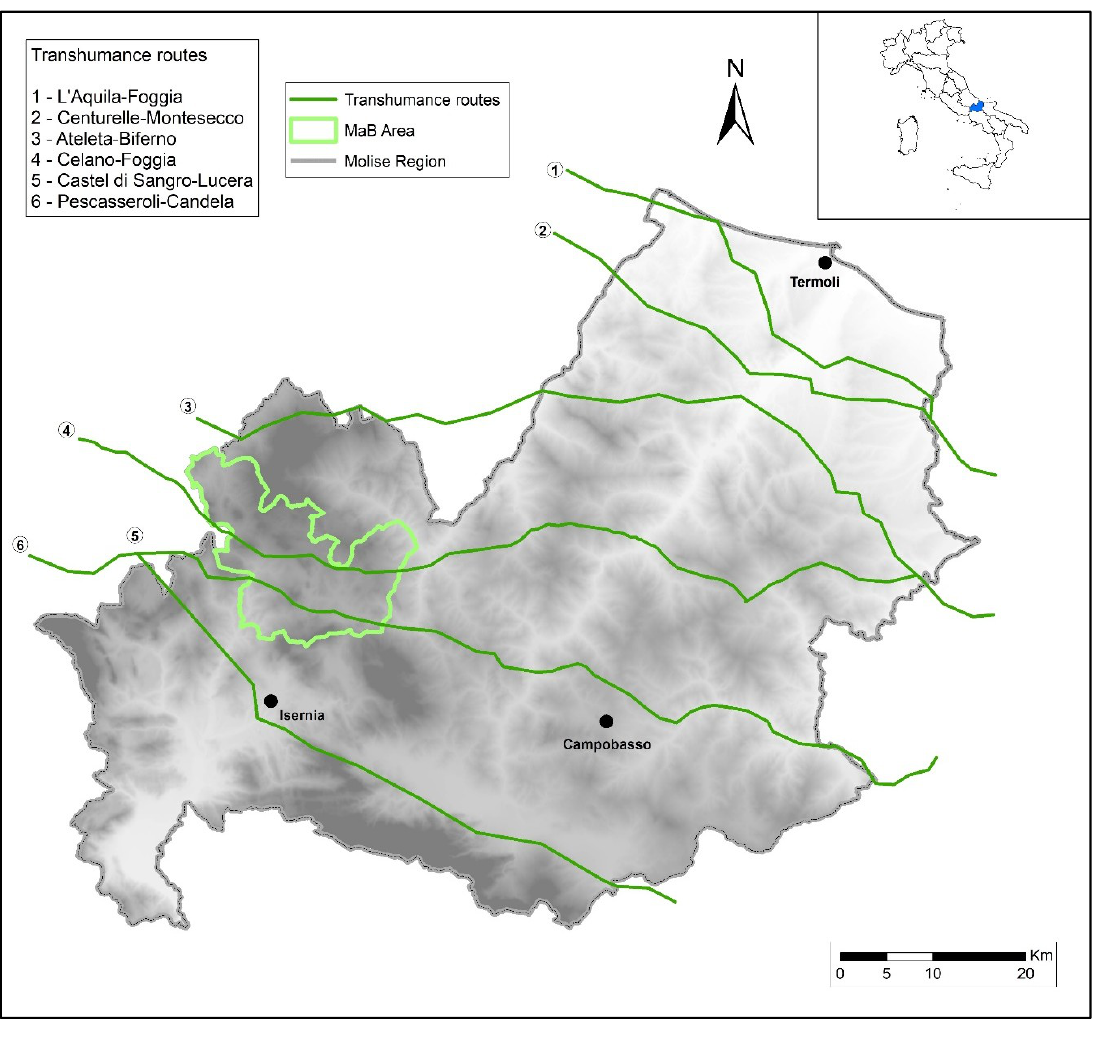
Figure 2. The localization of the study area.